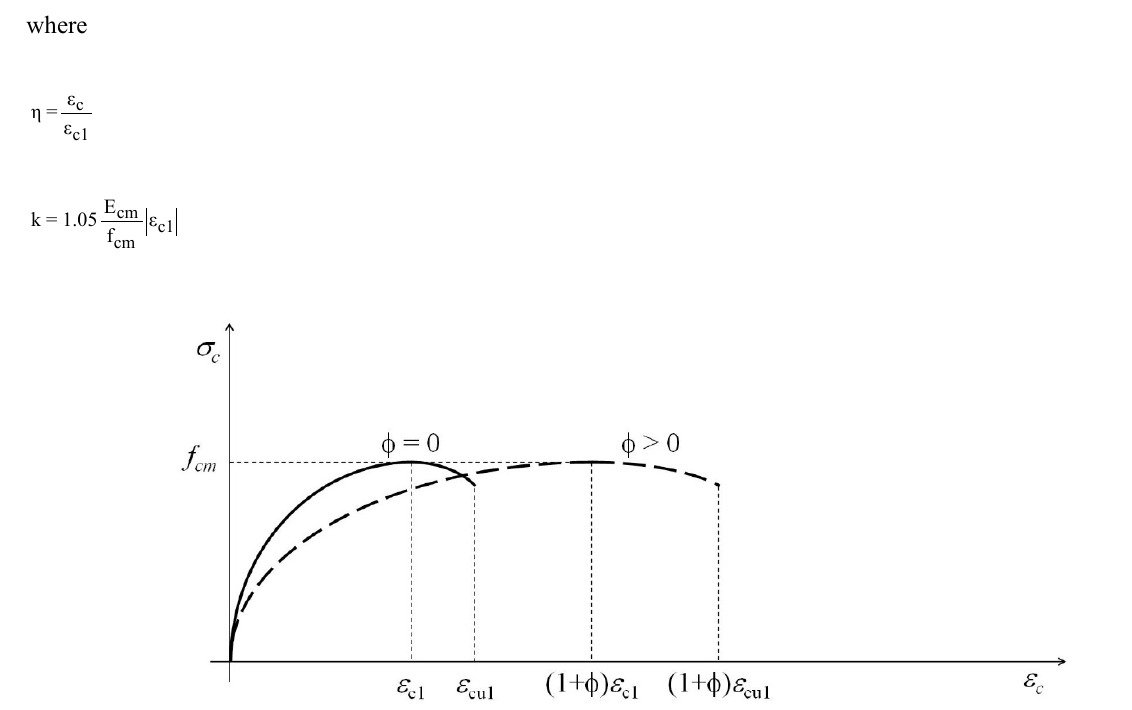
Figure 7. Constitutive model for non-linear analysis with